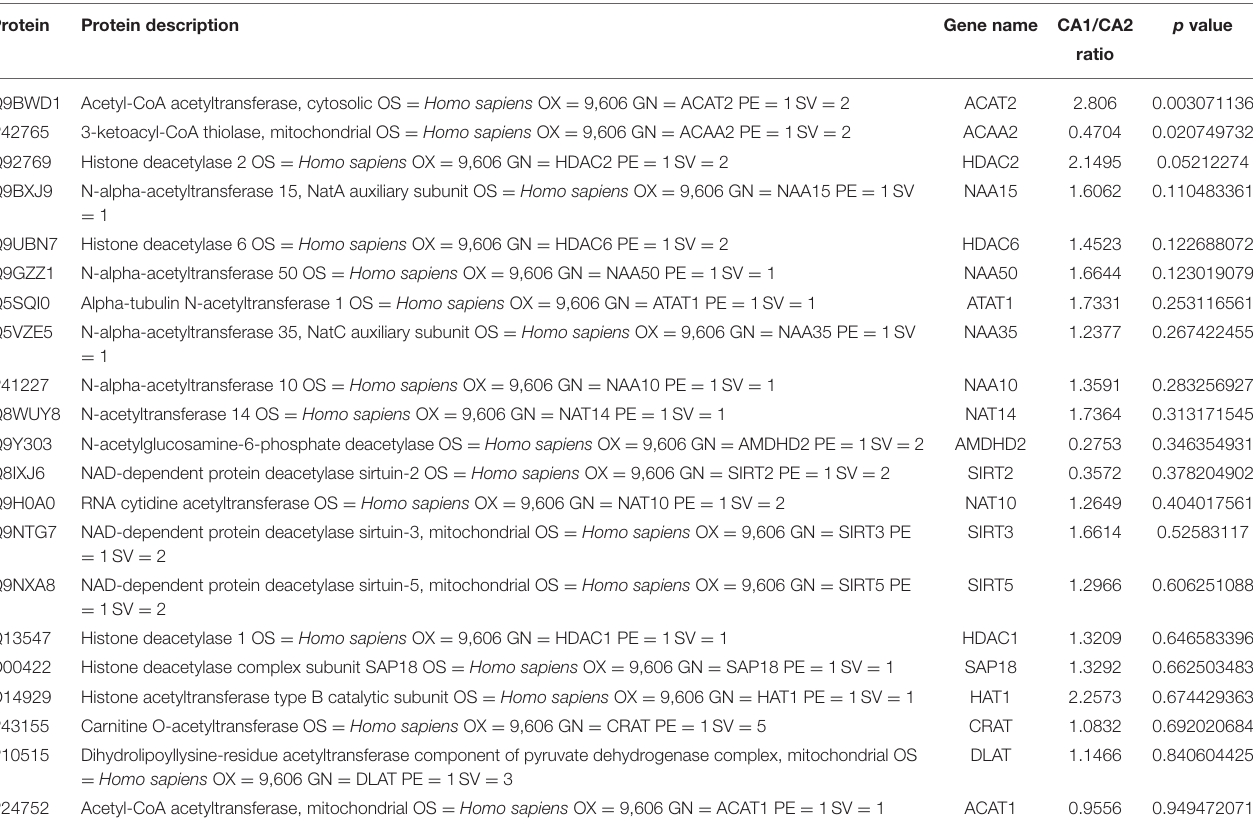
TABLE 1 | Acetylation-associated enzymes obtained in three paired samples. Protein Protein